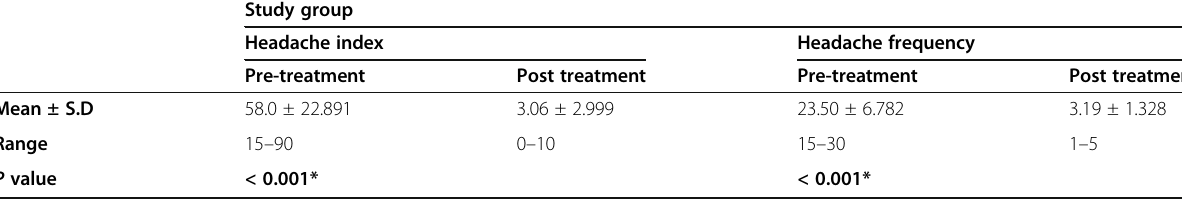
Table 3 Comparison of headache frequency and index before and after treatment within the study group Study group